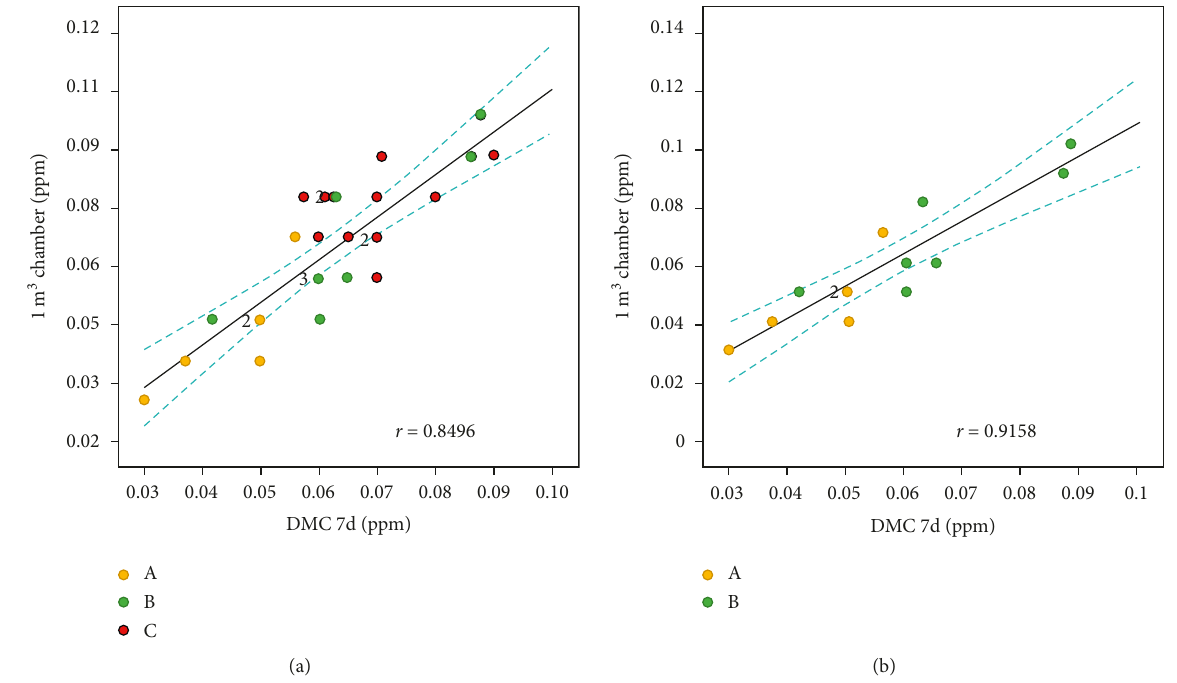
Figure 3: Correlation between the 1m 3 chamber (following ASTM D6007-14) and DMC chamber formaldehyde measurements (a) for all particleboard types (A, B, and C) and (b) for particleboard types A and B. Circles represent values measured from different production batches, dotted lines represent confidence bands, and the numbers before circles indicate more than one measurement at the same point. No outliers exist for (a) and (b). Upper and lower fences are 0.125 and 0.005 for (a) and 0.10 and 0.02 for